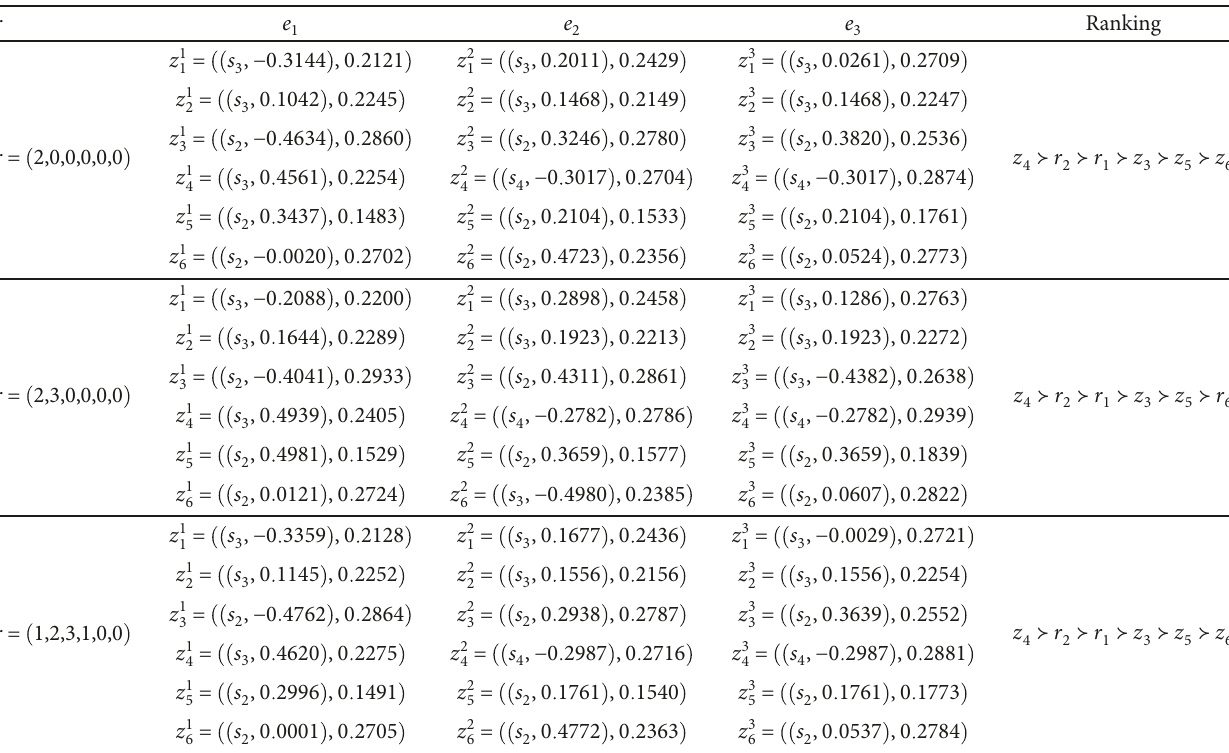
Table 8: The ranking results with the di ff erent values r (prioritization relationship e